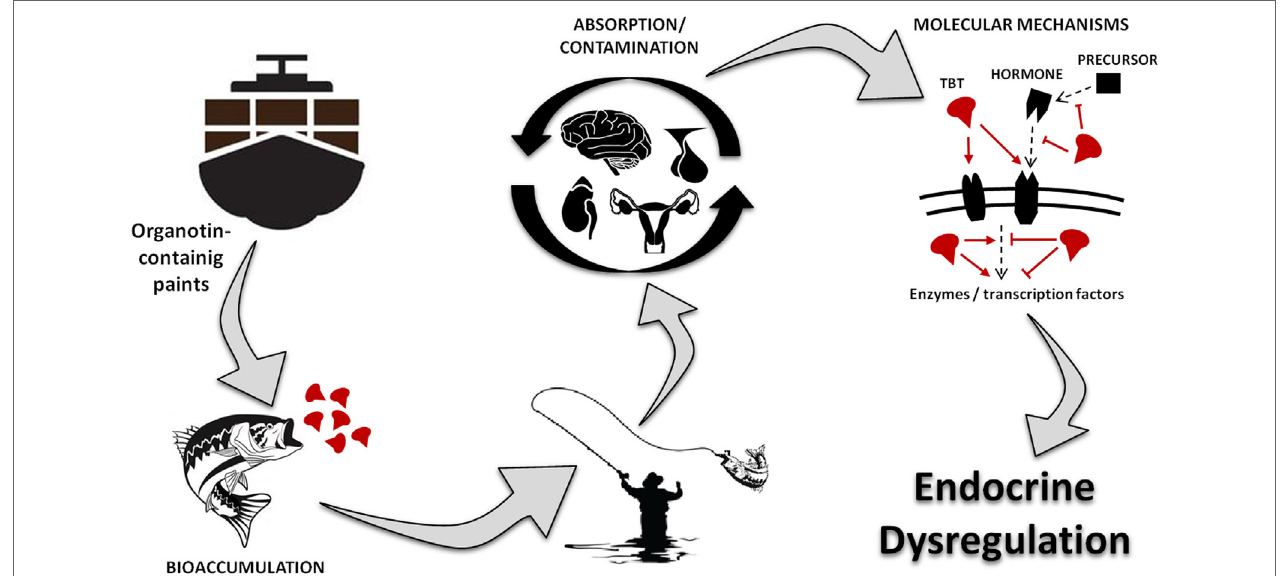
FigURe 1 | Visual abstract showing the main route of exposure to organotins for humans, underlying toxic mechanism and the potential consequences for the endocrine system. TBT, tributyltin.